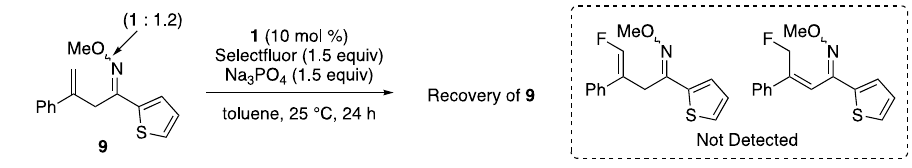
Scheme 3. Reaction of O -methylated compound.